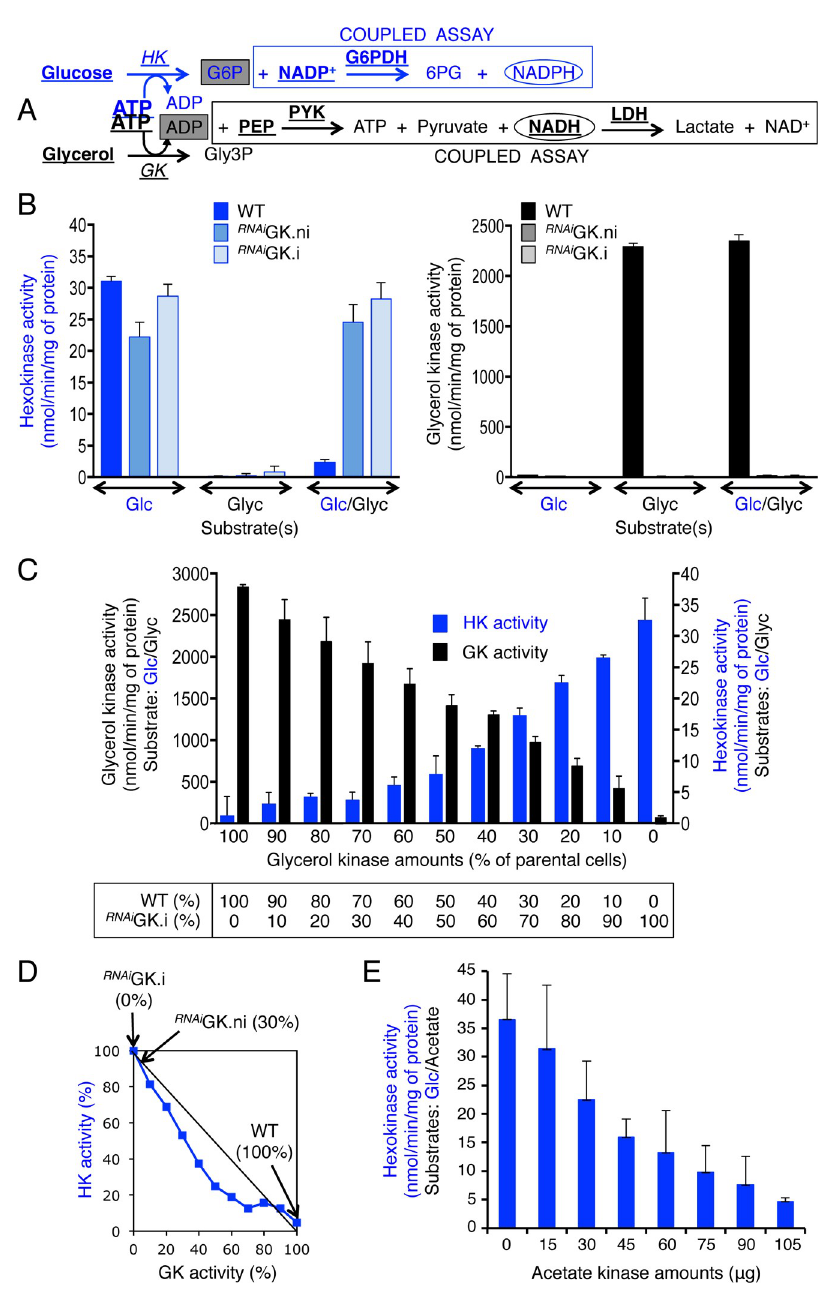
Fig 2. The glycerol preference is the consequence of the high excess of GK activity. (A) Enzymatic assays used for the quantification of hexokinase (HK) and glycerol kinase (GK) activity. The bold and underlined substrates and enzymes are included in the assay for production of NADPH (HK assay) and consumption of NADH (GK assay) that are detected by spectrometry at 350 nm. 6PG, 6-phosphogluconate; G6PDH, glucose-6-phosphate dehydrogenase; Gly3P, glycerol 3-phosphate; LDH, lactate dehydrogenase; PEP, phosphoenolpyruvate; PYK, pyruvate kinase. (B) HK (left panel) and GK (right panel) activity in total cell extracts (wild-type [WT], RNAi GK.i and RNAi GK.ni) determined in the presence of glucose (Glc), glycerol (Glyc) or equal amounts of glucose and glycerol (Glc/Glyc). (C) GK and HK activity in different combinations (indicated in the table below the graph) of total cell extracts from the parental (WT) and the RNAi GK.i cell lines. The amount of HK remained the same in all samples (see S2 Fig), while the amount of GK present in the parental samples was diluted with the GK-depleted RNAi GK.i samples. The HK and GK activity were determined in the presence of both glucose and glycerol, as in the Glc/Glyc condition (see [B]). (D) Expression of HK activity as a function of GK activity. The values in parentheses indicate the rate of glycerol consumption in the RNAi GK. ni and RNAi GK.i cells compared to the parental cells (100%) (see Fig 1F and 1G). (E) HK activity in the presence of